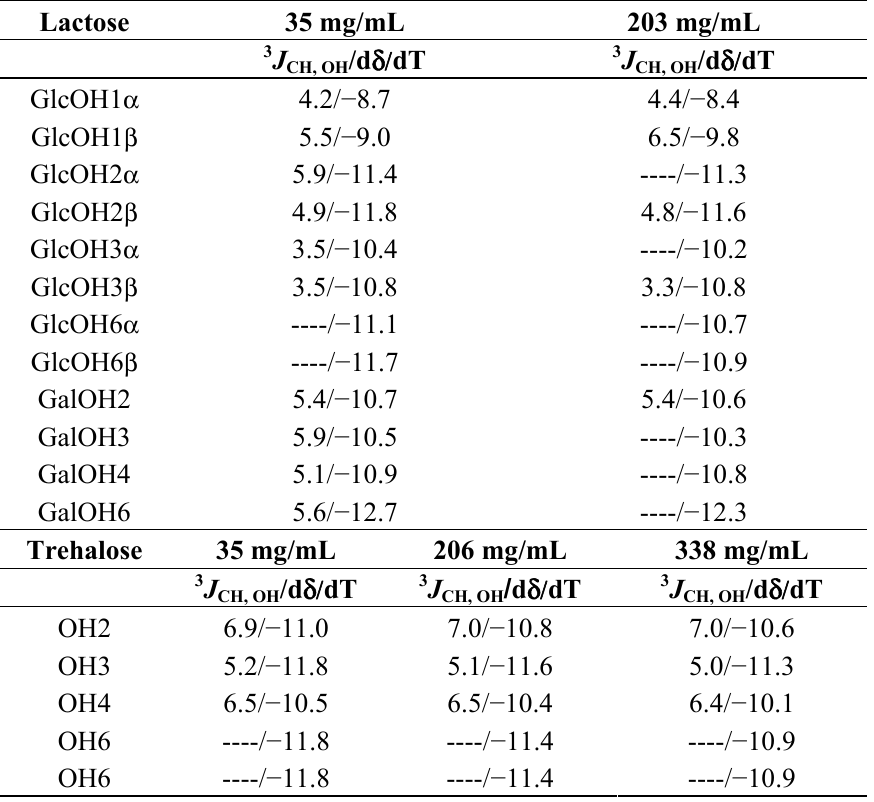
and d δ/ dT values for lactose and trehalose OH-protons in Table 1. 3 J CH, OH disaccharide/water binary mixtures. All coupling constants could not be extracted due to broad signals and/or